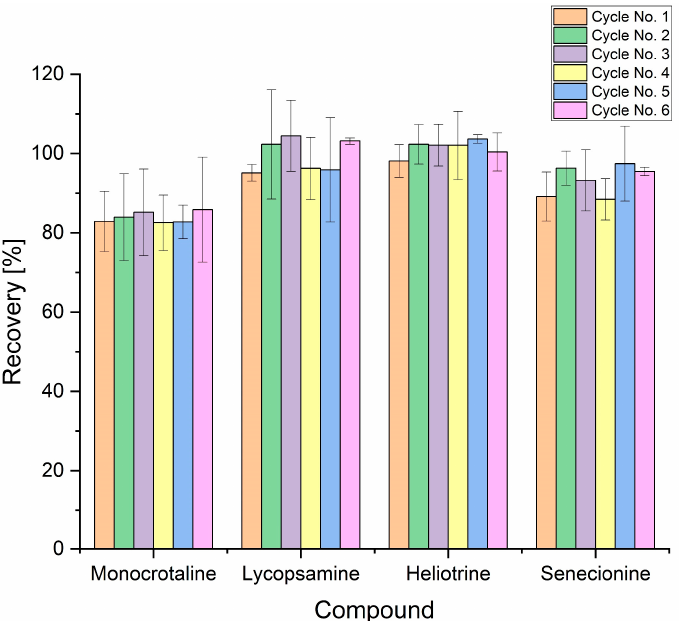
Figure 7. Recoveries of an aqueous 10.0 μ g L − 1 pyrrolizidine alkaloid mixture after six consecutive solid phase extractions with HNT-MPTMS-SO 3 H.